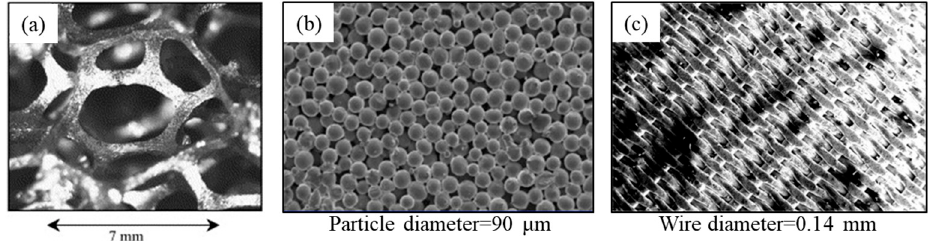
Figure 28. Typical porous material configurations: ( a ) open-cell metal foam (adapted with permission from [117], copyright 2003 Elsevier), ( b ) sintered metal particles (adapted with permission from [118], copyright 2012 Elsevier), and ( c ) sintered woven wire mesh (adapted with permission from [119], copyright 2015 Elsevier).